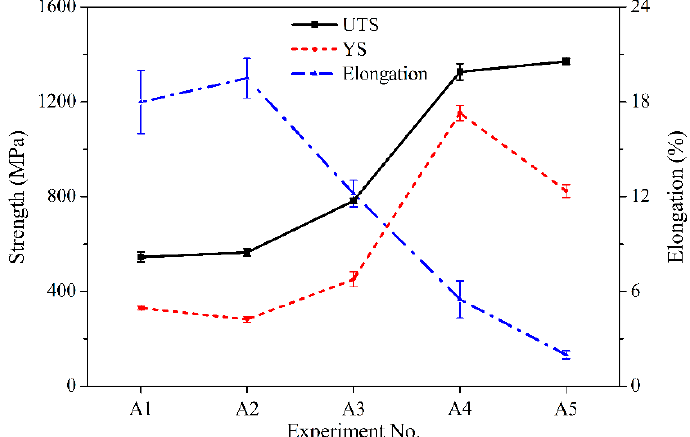
Figure 10. Ultimate tensile strength, yield strength, and elongation of deposited alloys at different concentrations of Fe–Cr–B–Si–Mo powder.